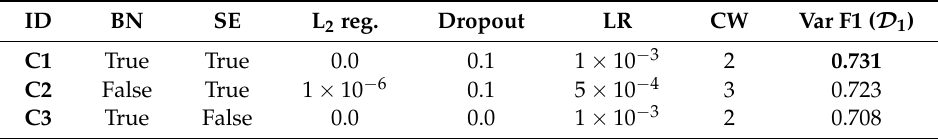
Table 4. Hyperparameters selection results. We report the 3 best configurations (C1, C2, C3) found with cross-validation on D 1 . Acronyms: BN (Batch Normalization), SE (Squeeze-and-Excitation), L 2 reg. (strength of the L 2 regularization on the network parameters), LR (Learning Rate), CW (weight of the oil